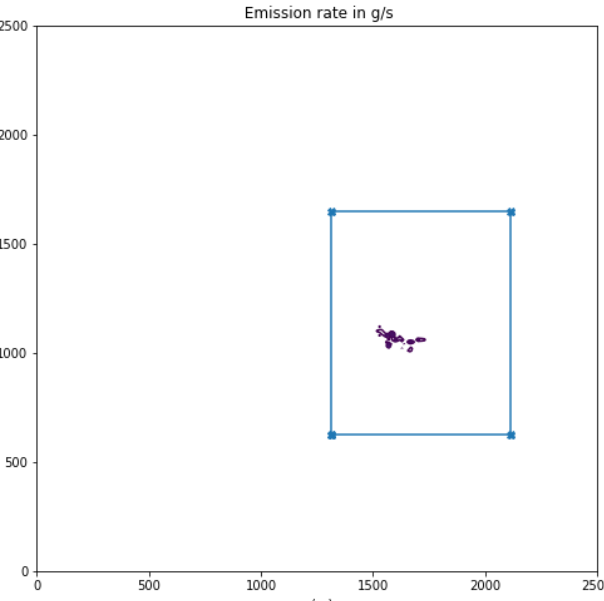
Figure 18. Inferred distribution of landfill emissions of methane on 28 September 2021, 9:01 a.m. to 9:54 a.m., based on drone and MPAL measurements. Contours are drawn for 1, 3, 5, and 10 g/s. Blue line is approximate border of the landfill.